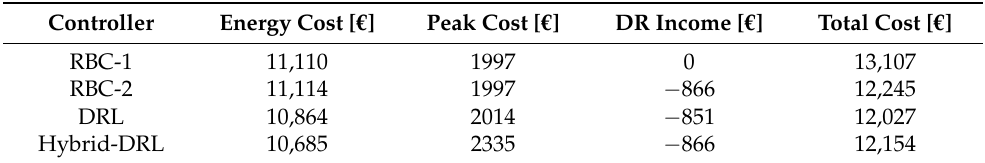
Table 5. Cost disaggregation: a comparison between the developed agents during the deployment phase.